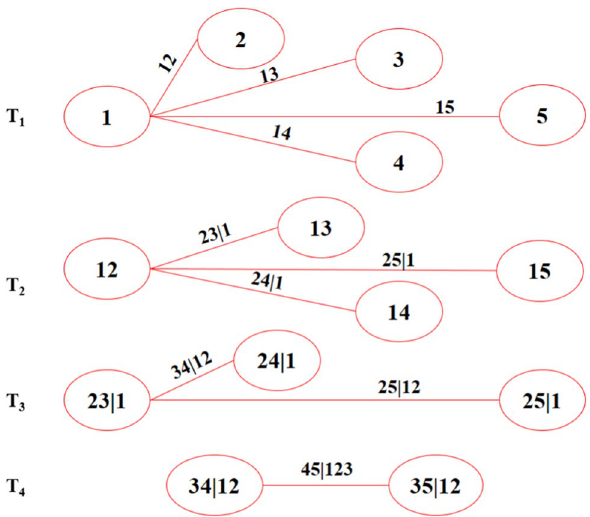
Fig. 3 C-vine copula with 5 variables, 4 trees and 10 edges (Aas et